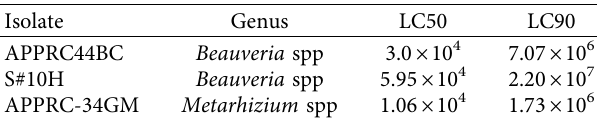
Table 4: LC50 and LC90 of two Beauveria and one Metarhizium strains against larvae of C.